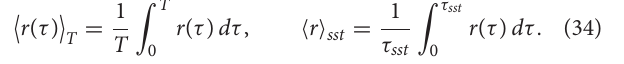
are mapped as a function of τ . Such maps are shown in Figure 6 , for several values of the ac flux amplitude, φ ac . In these maps, areas with uniform colorization indicate that the SQUID oscillators there are synchronized, while areas with non-uniform colorization indicate that they are